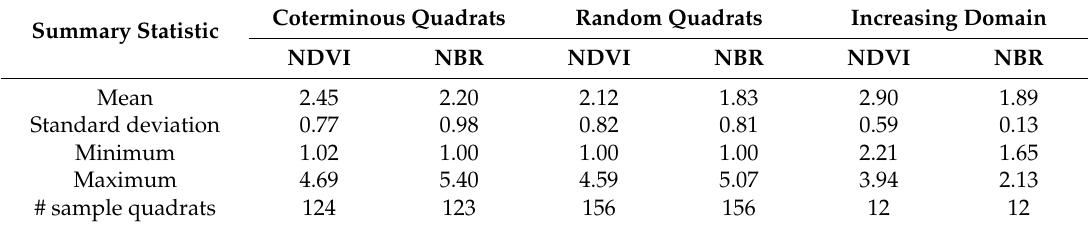
Table 4. The square root of VIF factors for the Florida Everglades remotely-sensed